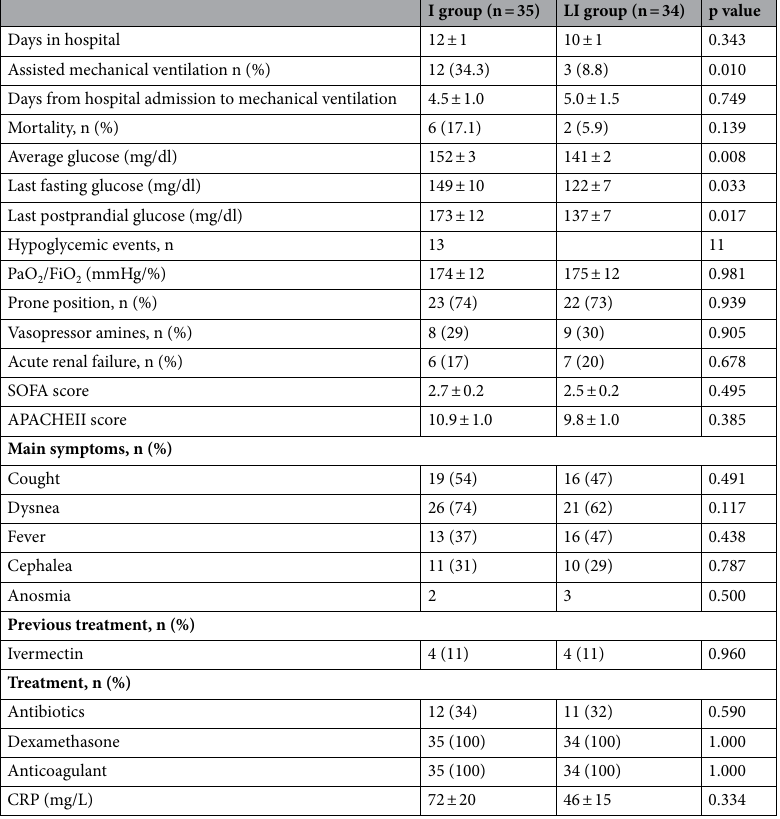
Table 2. Clinical evolution during hospitalization between the study groups. Data are mean ± SEM. PaO2/ FiO2 ratio between partial pressure of arterial oxygen and fraction of inspired oxygen, SOFA sequential organ failure assessment score, CRP C reactive protein.